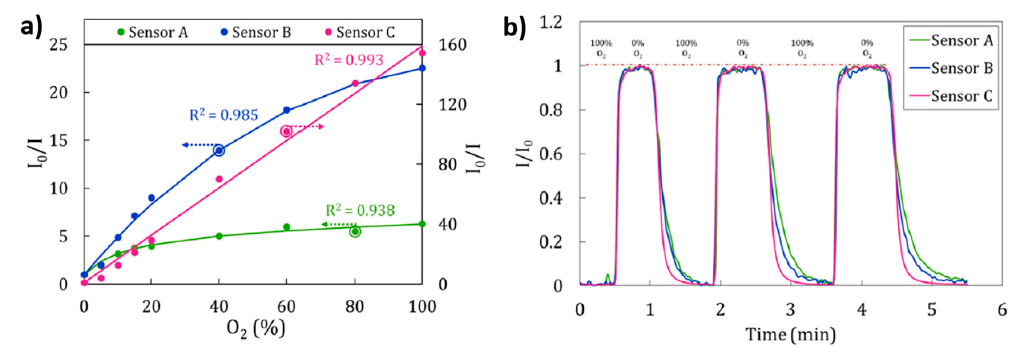
Figure 4. ( a ) Calibration curves of Sensors A (PDDA), B (PEI) and C (PAH). To make easier the comparison between the curves shapes, calibration curves of Sensors A and B are adjusted on the left axis, whereas that of Sensor C is adjusted on the right axis; ( b ) Response of the Sensors to dynamic variations of oxygen concentrations from 0% to 100% repeatedly in 3 cycles. Reprinted with permission from Ref. [28].